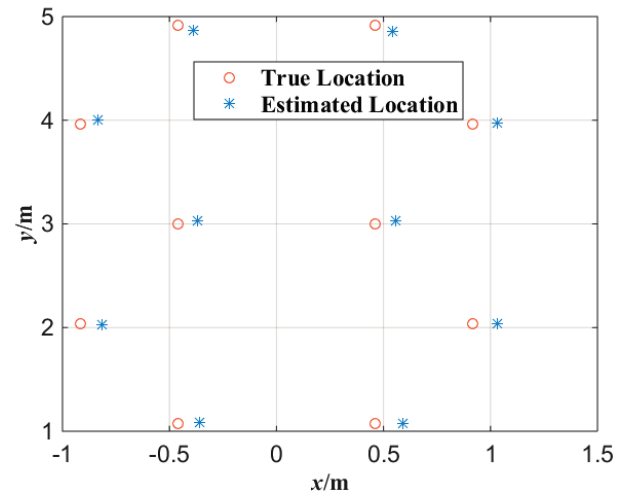
Figure 7. Experimental data of plane localization with the miner’s lamp video collaborative